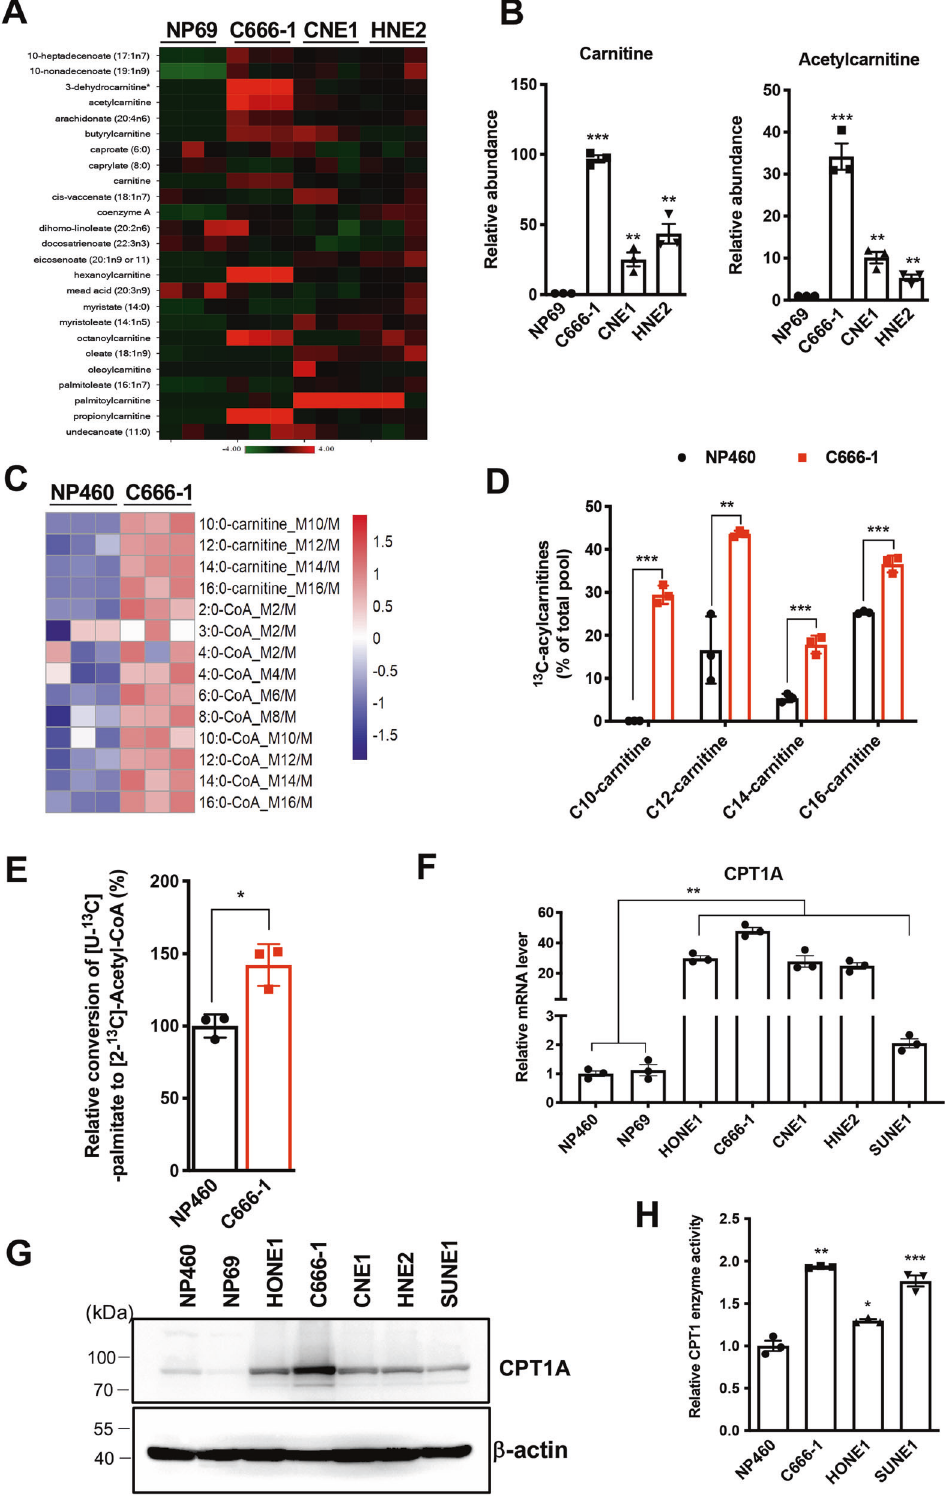
regulation promotes cell cycle progression, suggesting a bidirec- tional connection between cell division and general metabolism [15]. CPT1A-dependant FAO plays an essential role in the cell cycle progression of cancer cells. CPT1A may be a mechanistic link between lipid catabolism and cell cycle